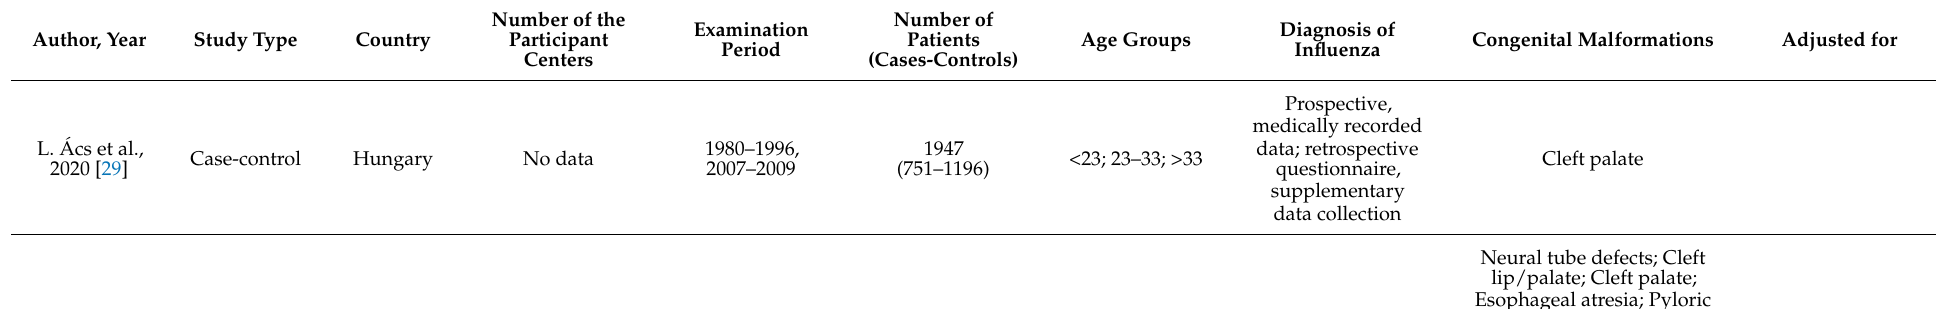
Table 1. Basic characteristics of included